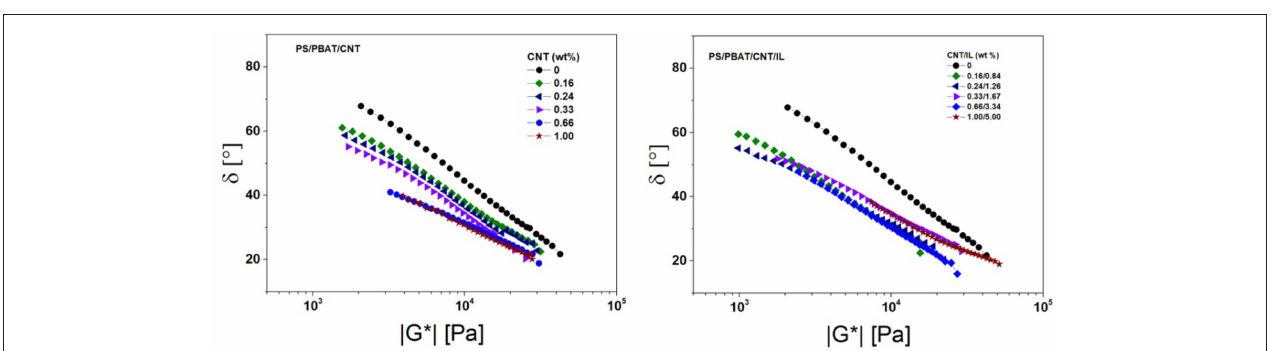
IL-CNT. For a similar |G ∗ |, the neat PS/PBAT blend